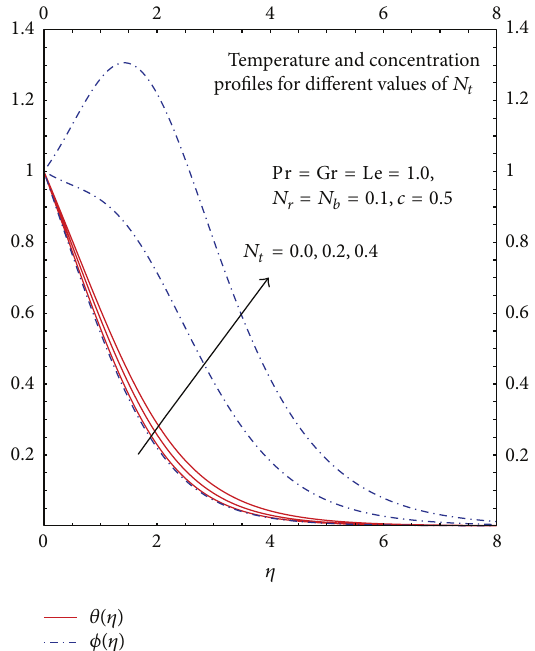
Figure 11: Graphs of 𝜃(𝜂) and 𝜙 𝜂 for different 𝑁 𝑡